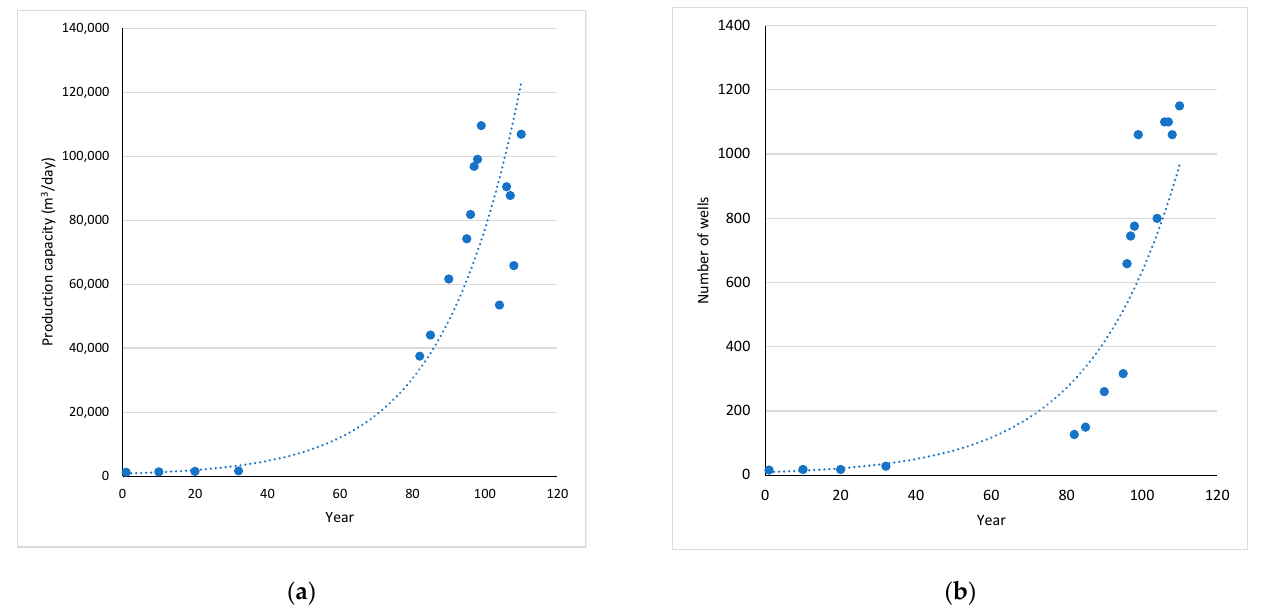
Figure 8. ( a ) Trendline of production capacity; ( b ) the number of registered deep wells. The first scenario (TS1) is a direct projection of the future water consumption from 2010 to 2050, which is calculated straightforwardly based on the two trendline equations gained in Figure 8 without any management measure. The second (TS2), third (TS3), and fourth (TS4) scenarios are the ones with the values computed from the two trendline equations for the period of 2010 to 2024, but from 2025 to 2050, TS2, TS3, and TS4 respectively represent different measures adopted to restore the groundwater level. A flat line is prescribed in the second scenario (TS2) for the registered deep wells and their production capacity between 2025 and 2050, physically indicating that the measure is proposed to prohibit the development of additional wells and groundwater production in this period. The third scenario (TS3) characterizes a more ambitious measure that is planned to reduce the number of the registered deep wells and their production capacity by 5% annually from 2025 to 2034 and then maintains them from 2035 to 2050. A same measure as the third scenario but with 10% reduction is formulated instead as the fourth scenario